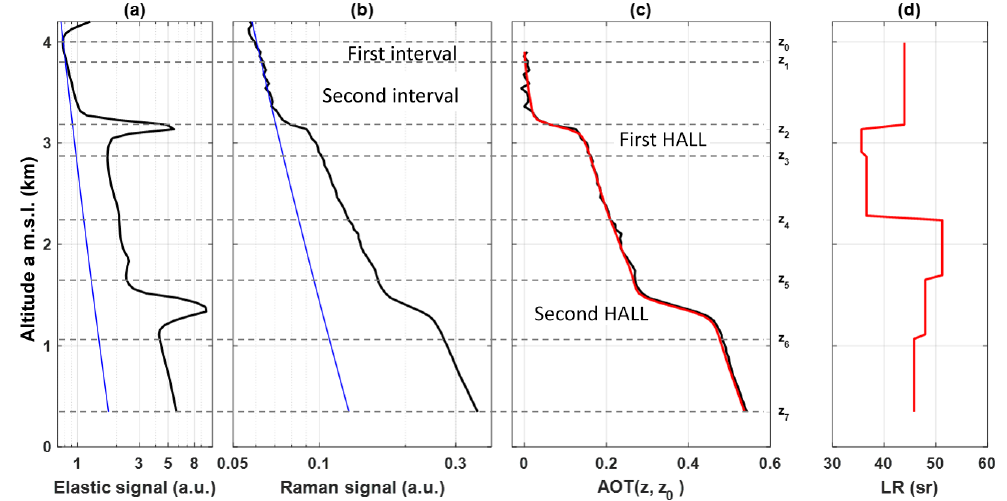
Figure 5. Example for the demonstration of the TDAM (top-down aerosol optical thickness matching) algorithm, which is an actual lidar measurement at ∼ 21:20UTC on 17 April (cf. Fig. 3). (a) Range-corrected elastic signal (black) with fitted molecular elastic signal (blue). (b) Range-corrected Raman signal (black) with fitted molecular Raman signal (blue). (c) Raman-derived AOT profile (black) with retrieved AOT profile using TDAM (red). Altitudes determining layers are shown by dotted lines, from which we can find the first altitude interval [ z 1 , z 0 ], the second altitude interval [ z 2 , z 1 ], and the i th altitude interval [ z i + 1 , z i ]. The two heavy aerosol load layers (HALLs) are also shown. (d) Retrieved LR profile using the TDAM algorithm.